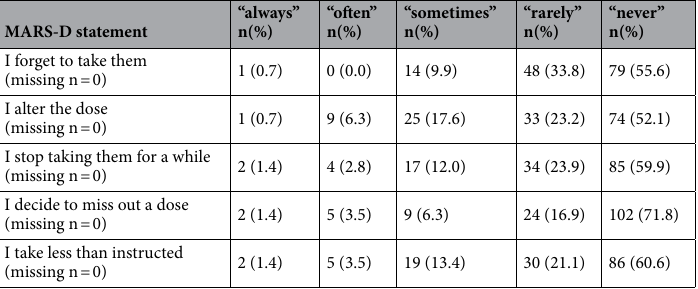
Table 3. Distribution of the response frequencies of the Medication Adherence Report Scale (MARS-D) in migraine patients (n =